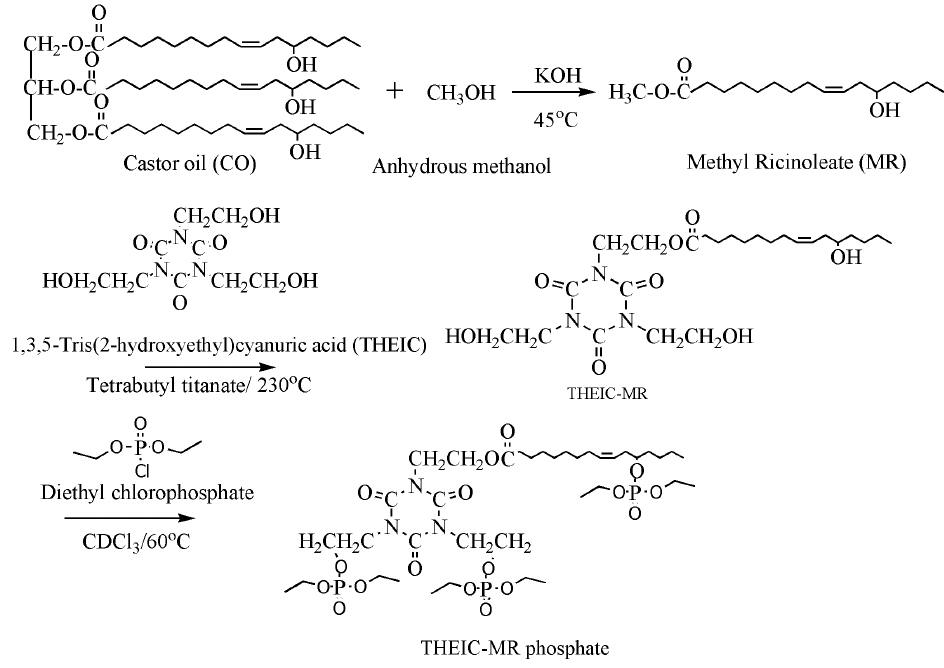
Figure 15. Flame retardant mechanism of DOPO groups-containing soybean oil polyol ester.